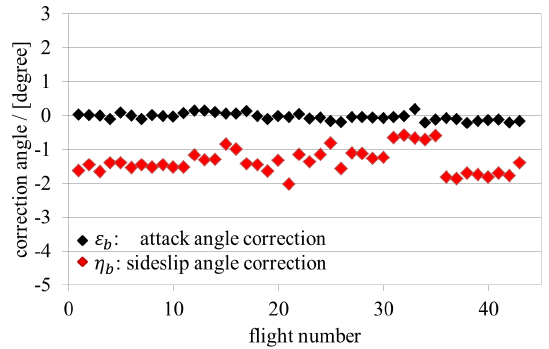
Figure 8. Results of the flow angle correction for 43 flights with the Caravan system after 2011. The correction for the attack angle offset shows significantly less scatter than for the sideslip angle. While the measurement system on the Falcon20 (see Fig. 2) is permanently installed, the system in the Caravan has to be reintegrated for each flight campaign. This leads to steps in the magnitudes of η b after a new integration of the measurement